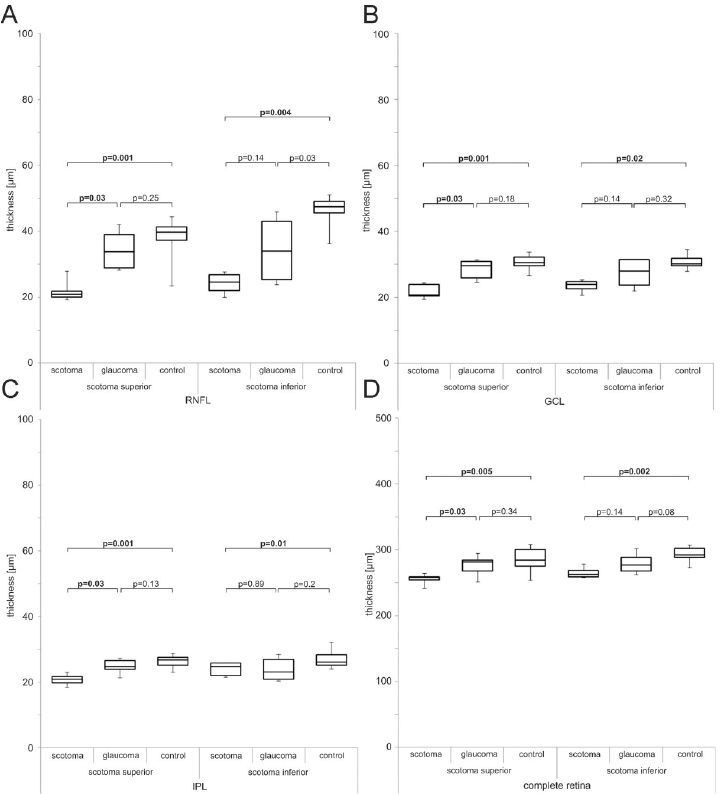
Fig 4. Hemifield comparison between glaucoma patients and control subjects. Box-and-whisker plots of the comparison of mean thickness of RNFL (A), GCL (B), IPL (C) and entire retina (D) between glaucoma group and control group related to the localization of the absolute visual field scotoma in superior or inferior hemifields.